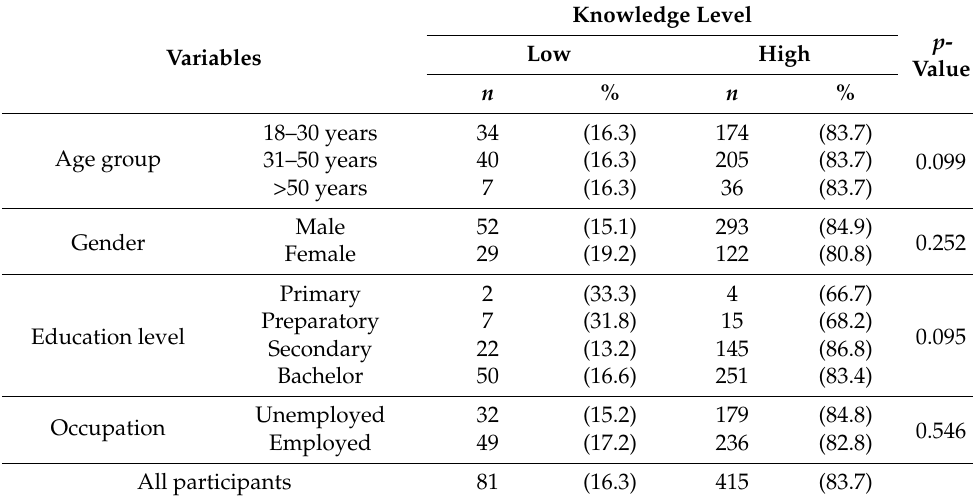
Table 4. Association between demographics and knowledge